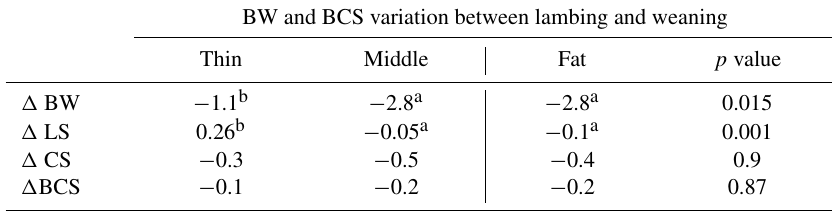
BW and BCS variation between lambing and weaning Thin Middle Fat p value